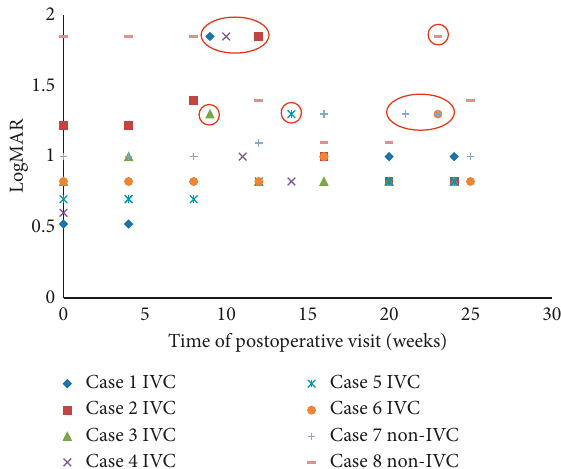
Figure 1: BCVA of the fellow eye during postoperative follow-up. Decreased BCVA occurred in 5 cases (all from the IVC group) around 3months (from 9weeks to 14weeks), the time when tractional retinal detachment was diagnosed (red circles). Three cases were diagnosed with tractional retinal detachment at 21weeks and 23weeks following surgery in the contralateral eye, but BCVA decreased only in 2